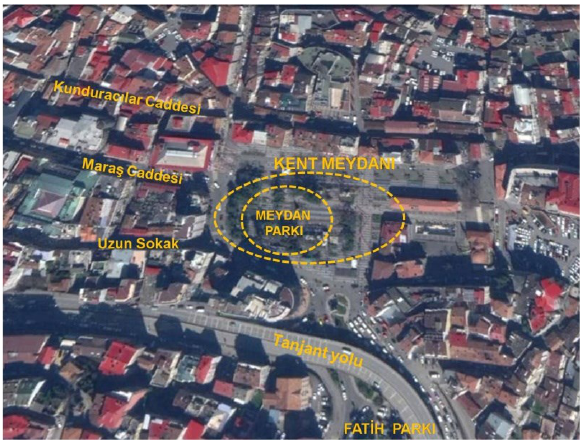
Figure 3. Trabzon City Square and its surroundings (URL-2